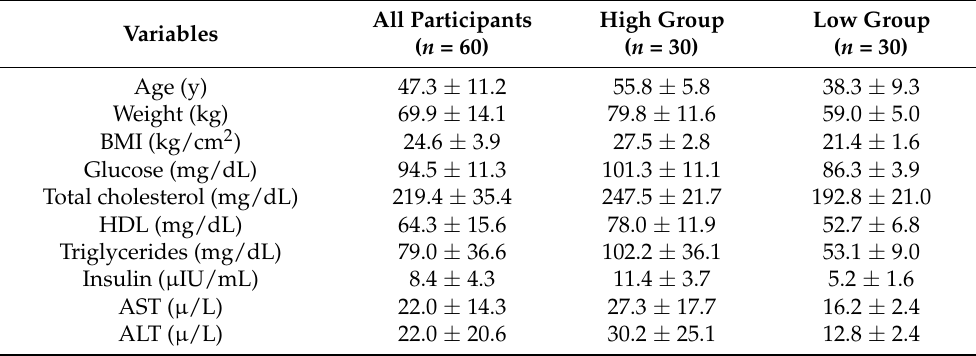
Table 1. Characteristics of the participants.